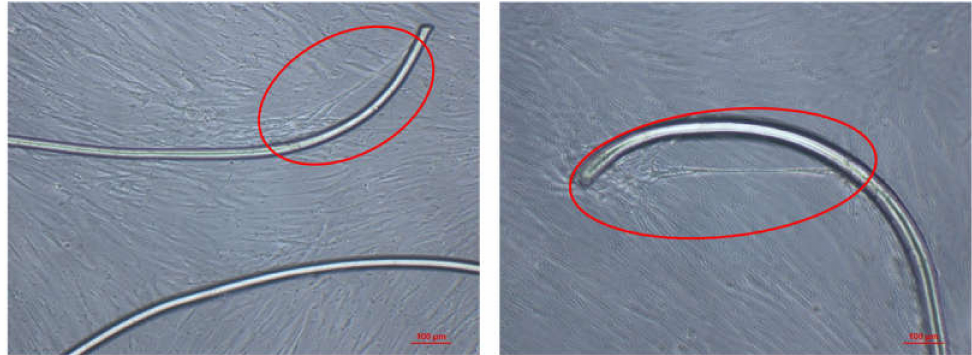
Figure 9. The images of a human cells attached to the PA6